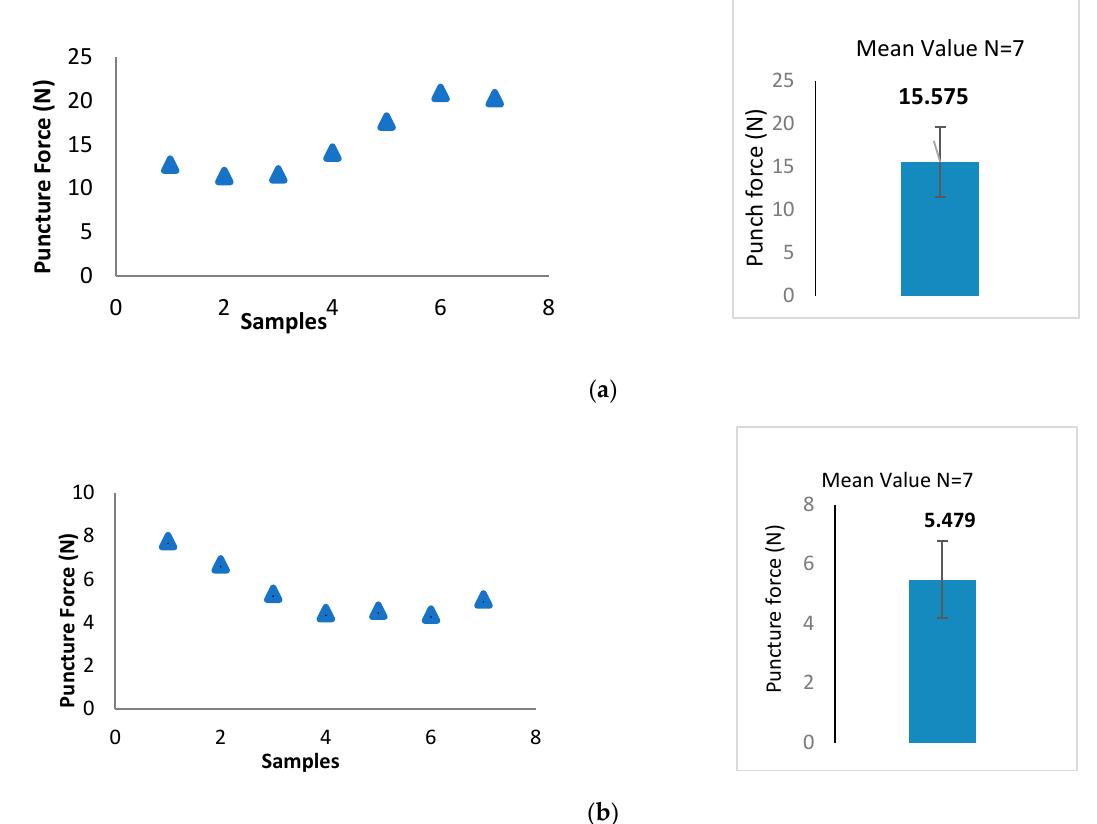
Figure 7. Comparison of ( a ) punch force with hemispherical indenter and ( b ) puncture force with BRK needle.